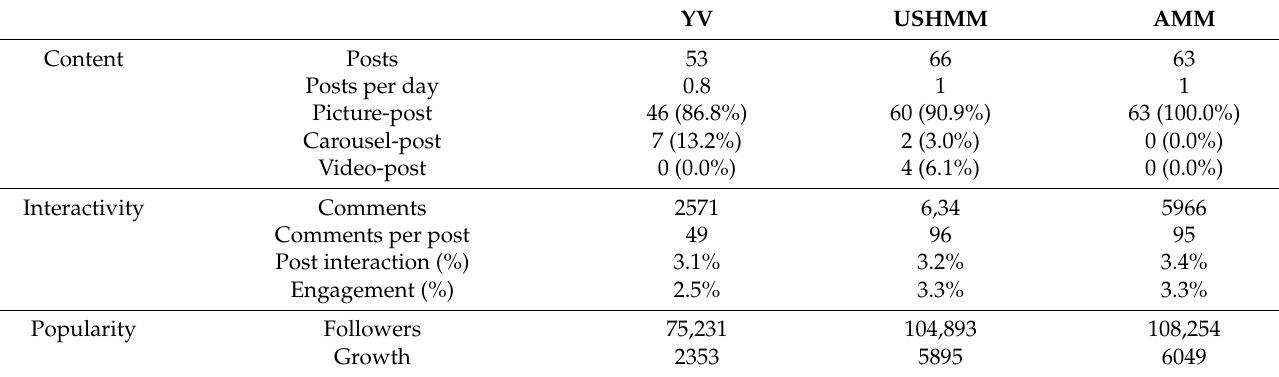
Table 5. Content, interactivity, and popularity of museums’ Instagram